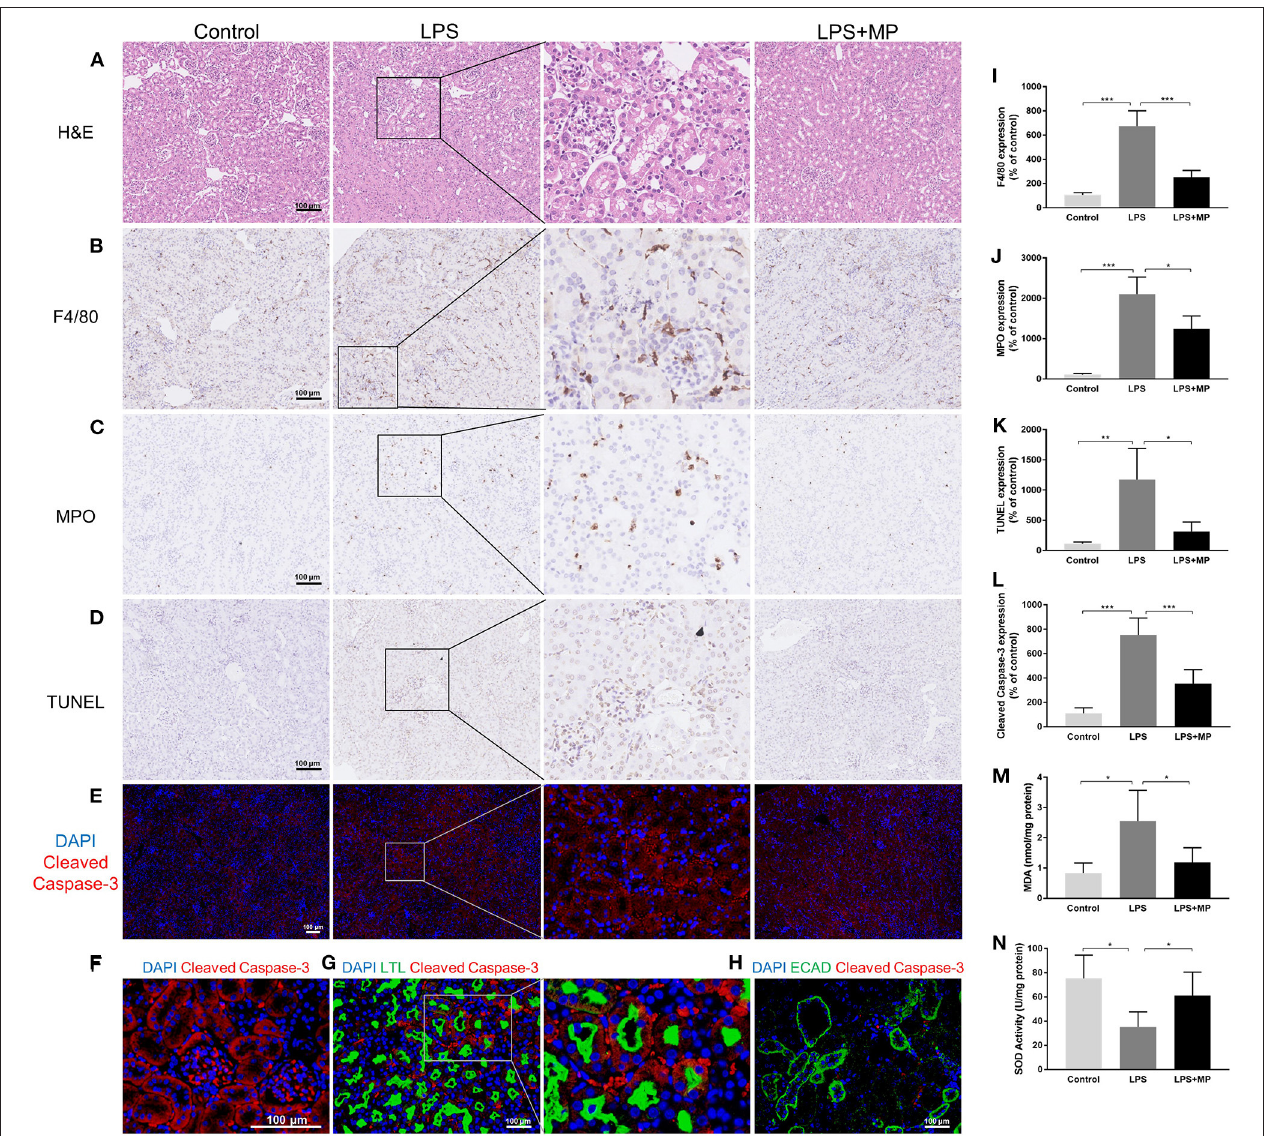
FIGURE 2 | LPS induces pathological changes as well as oxidative stress in the kidney and was ameliorated by MP treatment. (A) Representative images of hematoxylin and eosin (H&E) staining of kidney sections from the control, LPS, and LPS + MP treatment group. (B) Representative images of immunohistochemistry staining of the macrophage marker, F4/80 in kidney sections. (C) Representative images of immunohistochemistry staining of the neutrophil marker, myeloperoxidase (MPO) in kidney sections. (D) Representative images of the terminal deoxynucleotidyl transferase dUTP nick end labeling (TUNEL) assay and (E) cleaved Caspase-3 (Red) in kidney sections. (F) Magnification of cleaved Caspase-3 (Red) expression in the glomerular area of the LPS group. (G) Expression pattern of the proximal tubular marker Lotus Tetragonolobus Lectin (LTL) (Green) as well as cleaved Caspase-3 (Red) in the LPS group. (H) Expression pattern of the distal tubular marker ECAD (Green) as well as cleaved Caspase-3 (Red) in the LPS group. The 6-diamidino-2-phenylindole (DAPI) is stained with blue fluorescence. The corresponding semi-quantitative analysis of (I) F4/80, (J) MPO, (K) TUNEL, and (L) cleaved Caspase-3. (M) MDA concentration of mice kidney tissues. (N) SOD activity of